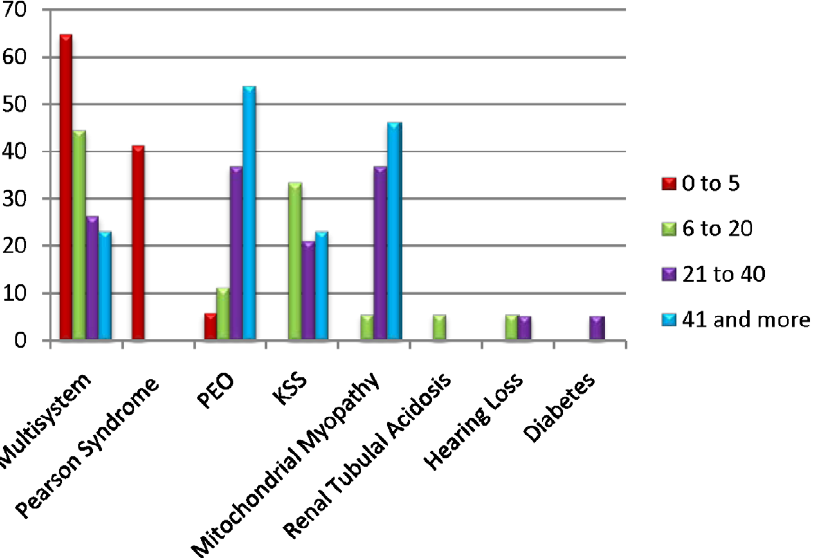
Figure 5. Clinical diagnosis and clinical manifestations in patients with mtDNA deletions. Y axix indicates the percentages of samples with a specific clinical diagnosis indicated in Table